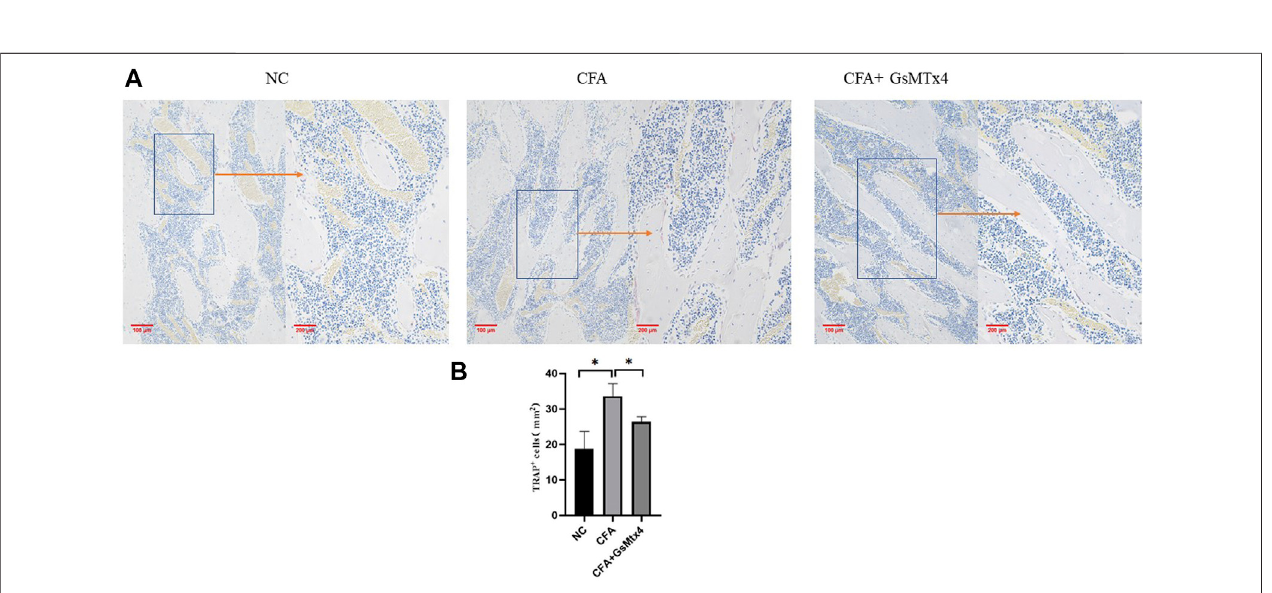
Frontiers in Physiology |